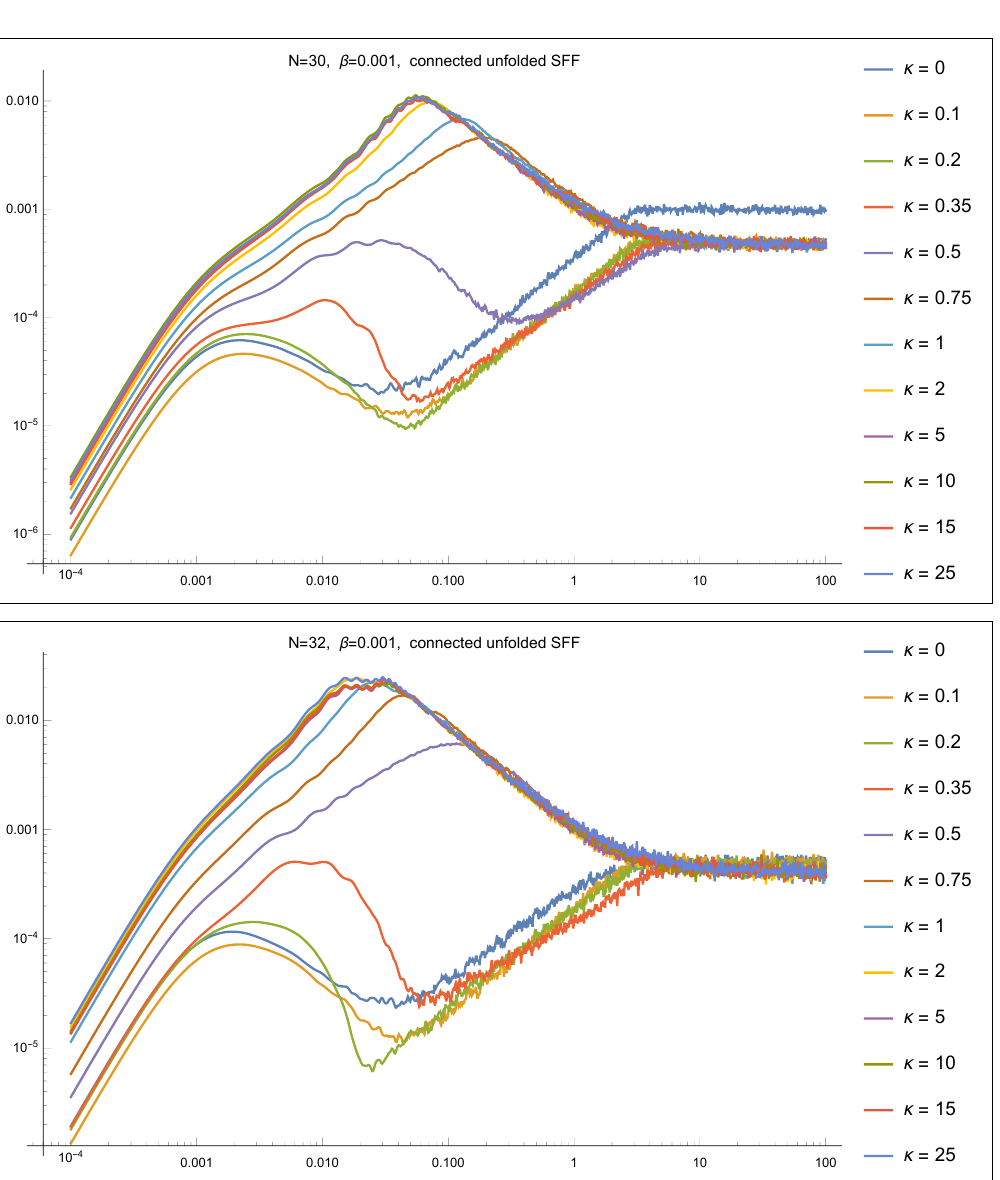
Figure 5 . The connected unfolded SFF for N = 30 ; 32 and (cid:12) = 0 :